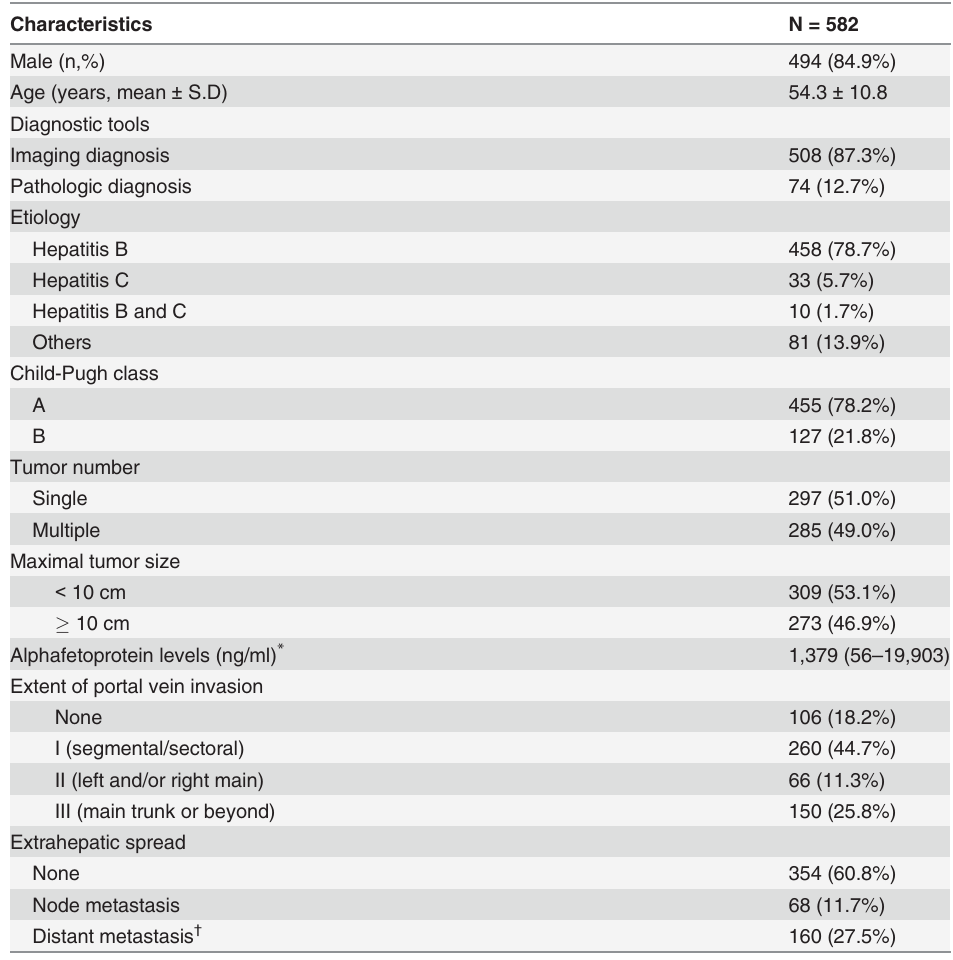
Table 1. Baseline